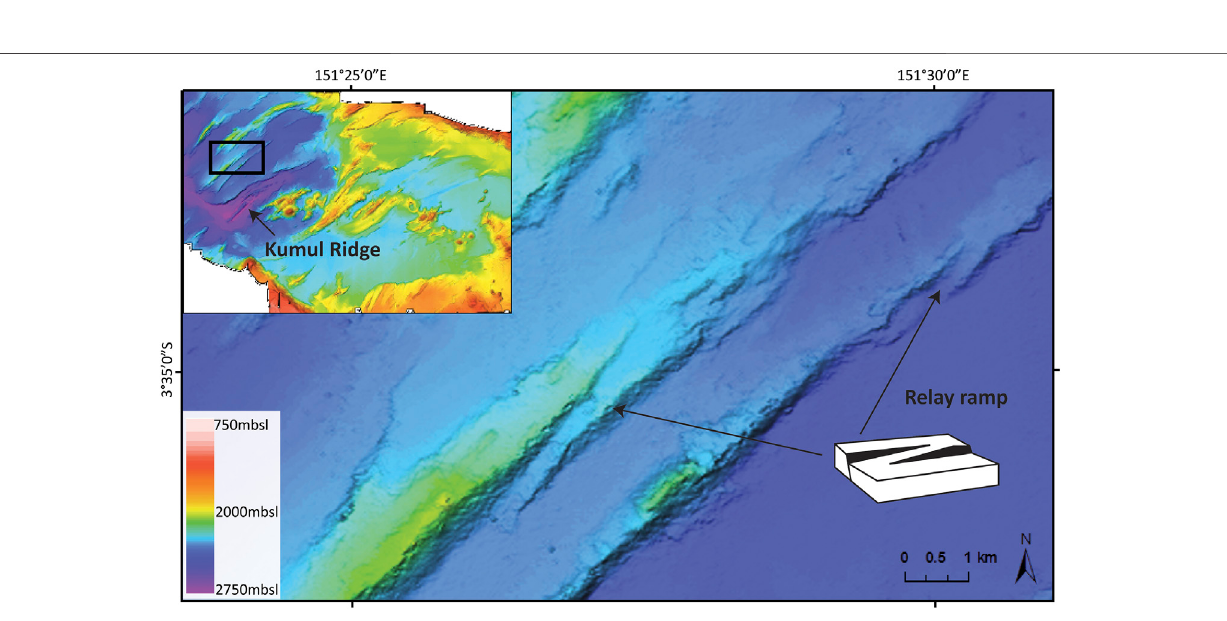
Frontiers in Earth Science |